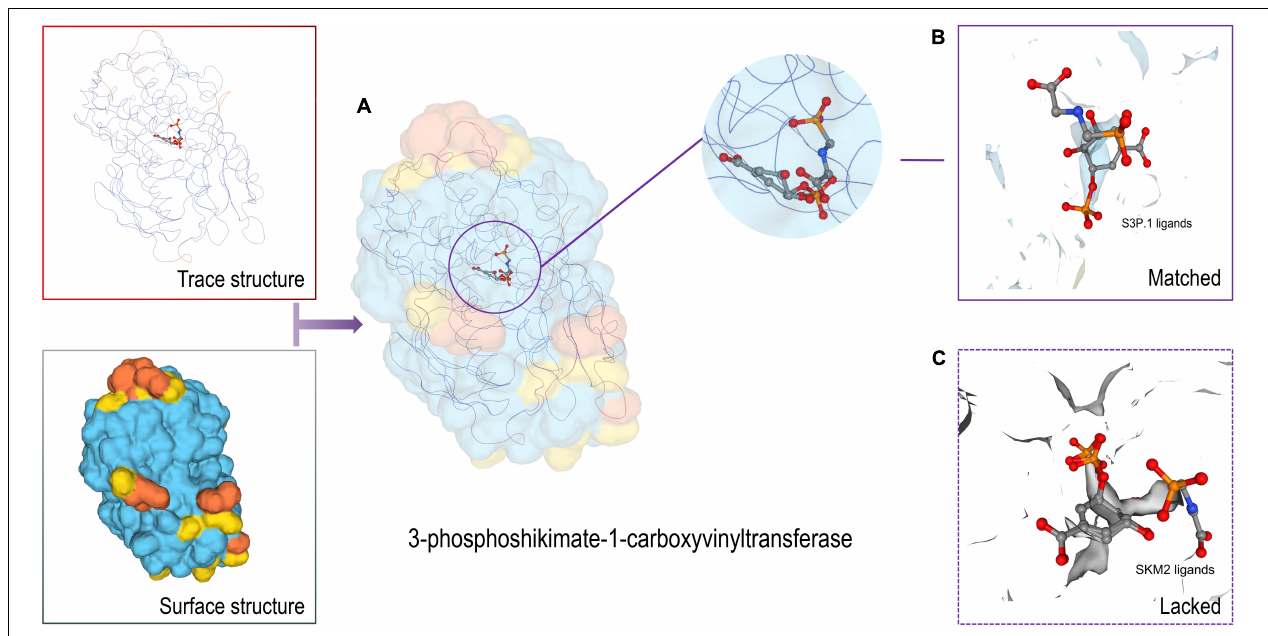
FIGURE 5 | 3D model structure of protein and ligands ( A : 3-phosphoshikimate-1-carboxyvinyltransferase; B : S3P.1 ligands; C : SKM2 ligands).